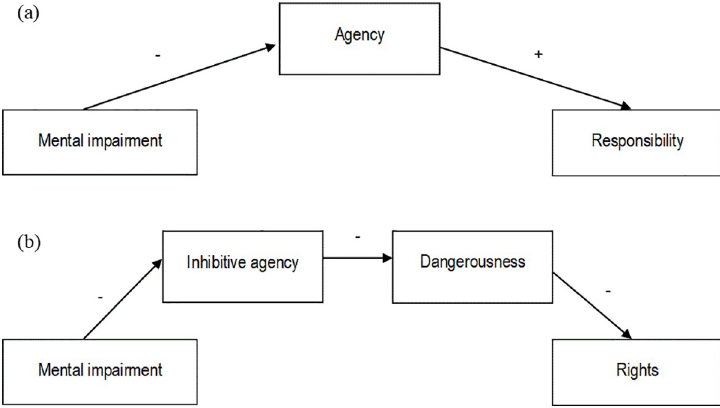
Fig 1. Models of the effects of using the defense of mental impairment on (a) responsibility; and (b) rights.